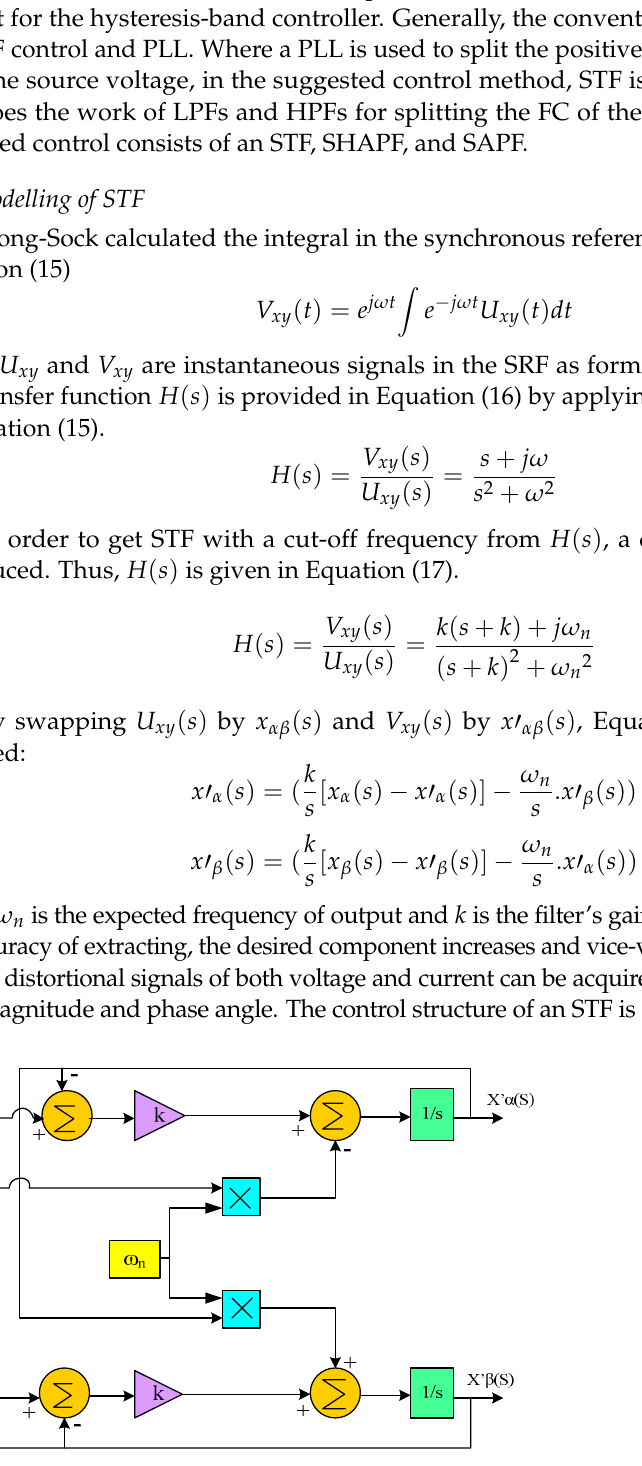
Figure 5. The control structure of STF.